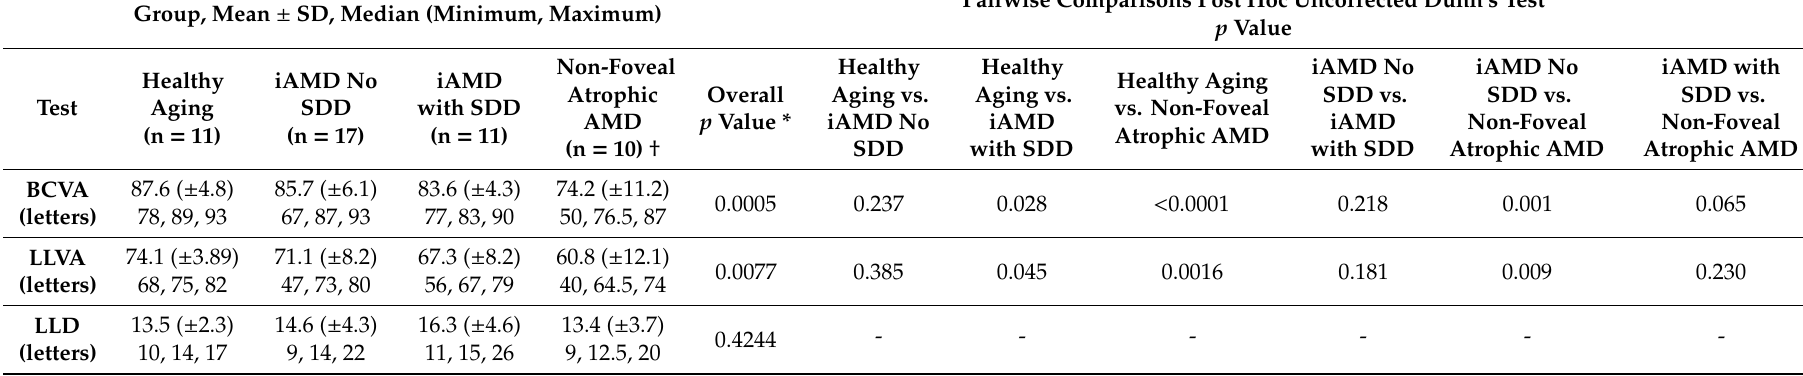
Table 1. Cross-sectional analysis at baseline for all functional outcome measures for all